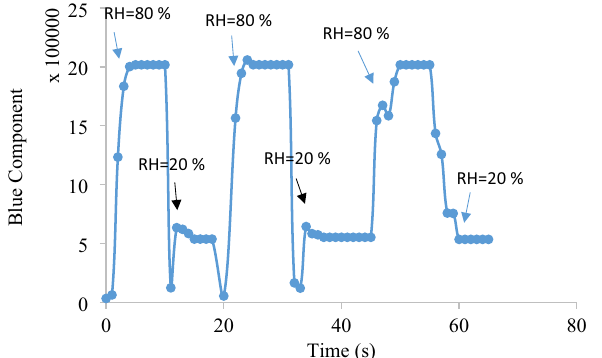
Figure 10. Diagram representing the hysteresis of the fabricated sensor Conditions: standard RH: 20 and 80% (Sequential introduction), applied voltages: 110 ± 1 V (AC, vs. GND), pressure: 25–30 torr, and temperature 40–45 °C. The data are the average of three independent analyses. Error bar: ± relative standard